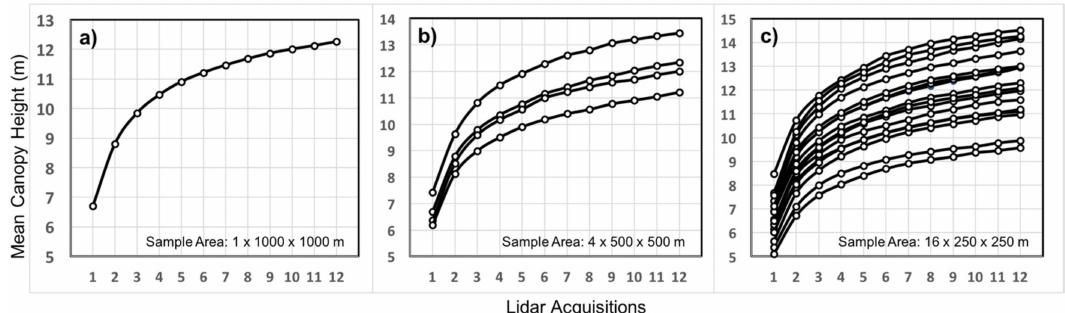
Figure 8. Mean canopy height (MCH) calculated using a canopy height model (CHM) derived from increasing lidar acquisitions over area of 1000 m × 1000 m, showing ( a ) differences over the entire area, ( b ) when divided into four subsamples (at 500 m × 500 m), and ( c ) when divided further in 16 subsamples (at 250 × 250 m). The graphs shown are computed by averaging the values calculated by shuffling the order of lidar acquisitions (1–12) five times to remove the impact of eventual bias (e.g., tree